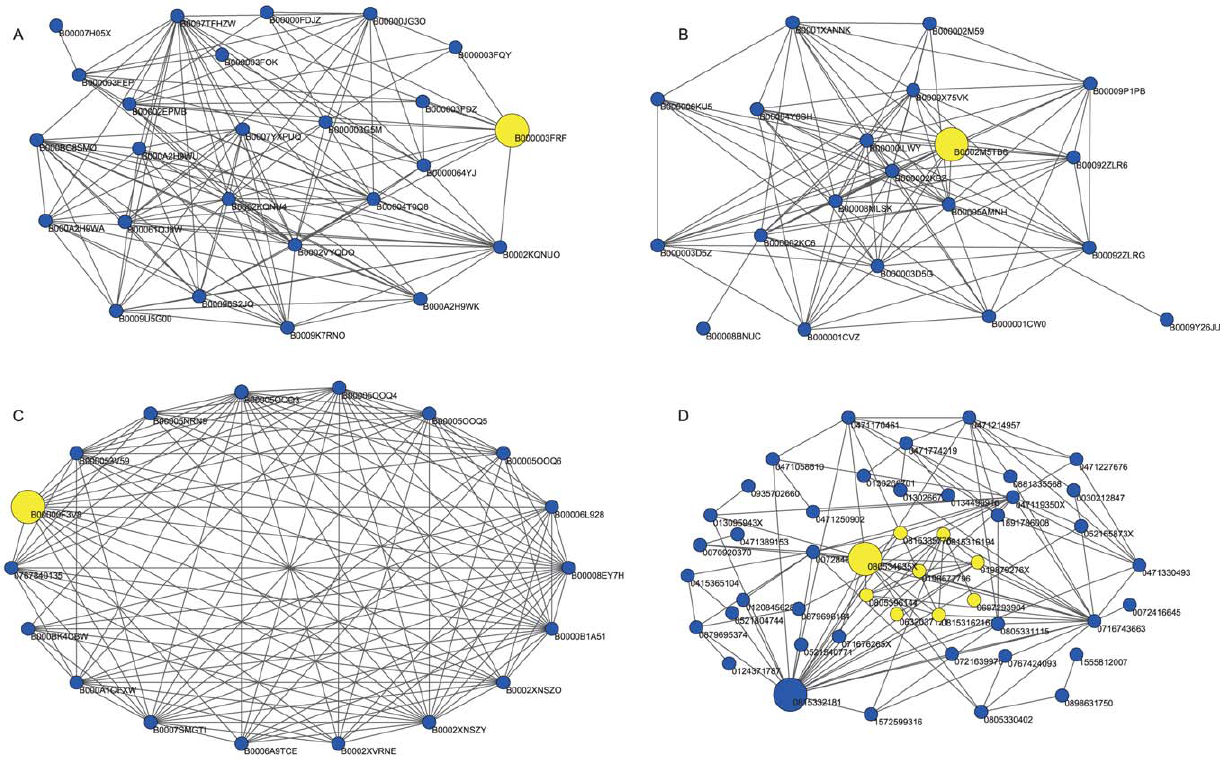
Figure 6. Identified local communities from different starting vertex in the Amazon co-purchase network. (A) Local community for the compact disc Algeria (ID B000003FRF), (B) local community for the DVD Cirque Reinvente (ID B00000F3V8), (C) local community for the compact disc Love Wants to Dance (ID B0002M5TB6), and (D) local community for the book Molecular Biology of Cell (ID 0815332181) and the book Molecular Biology of the Gene (ID 080534635X)(marked in